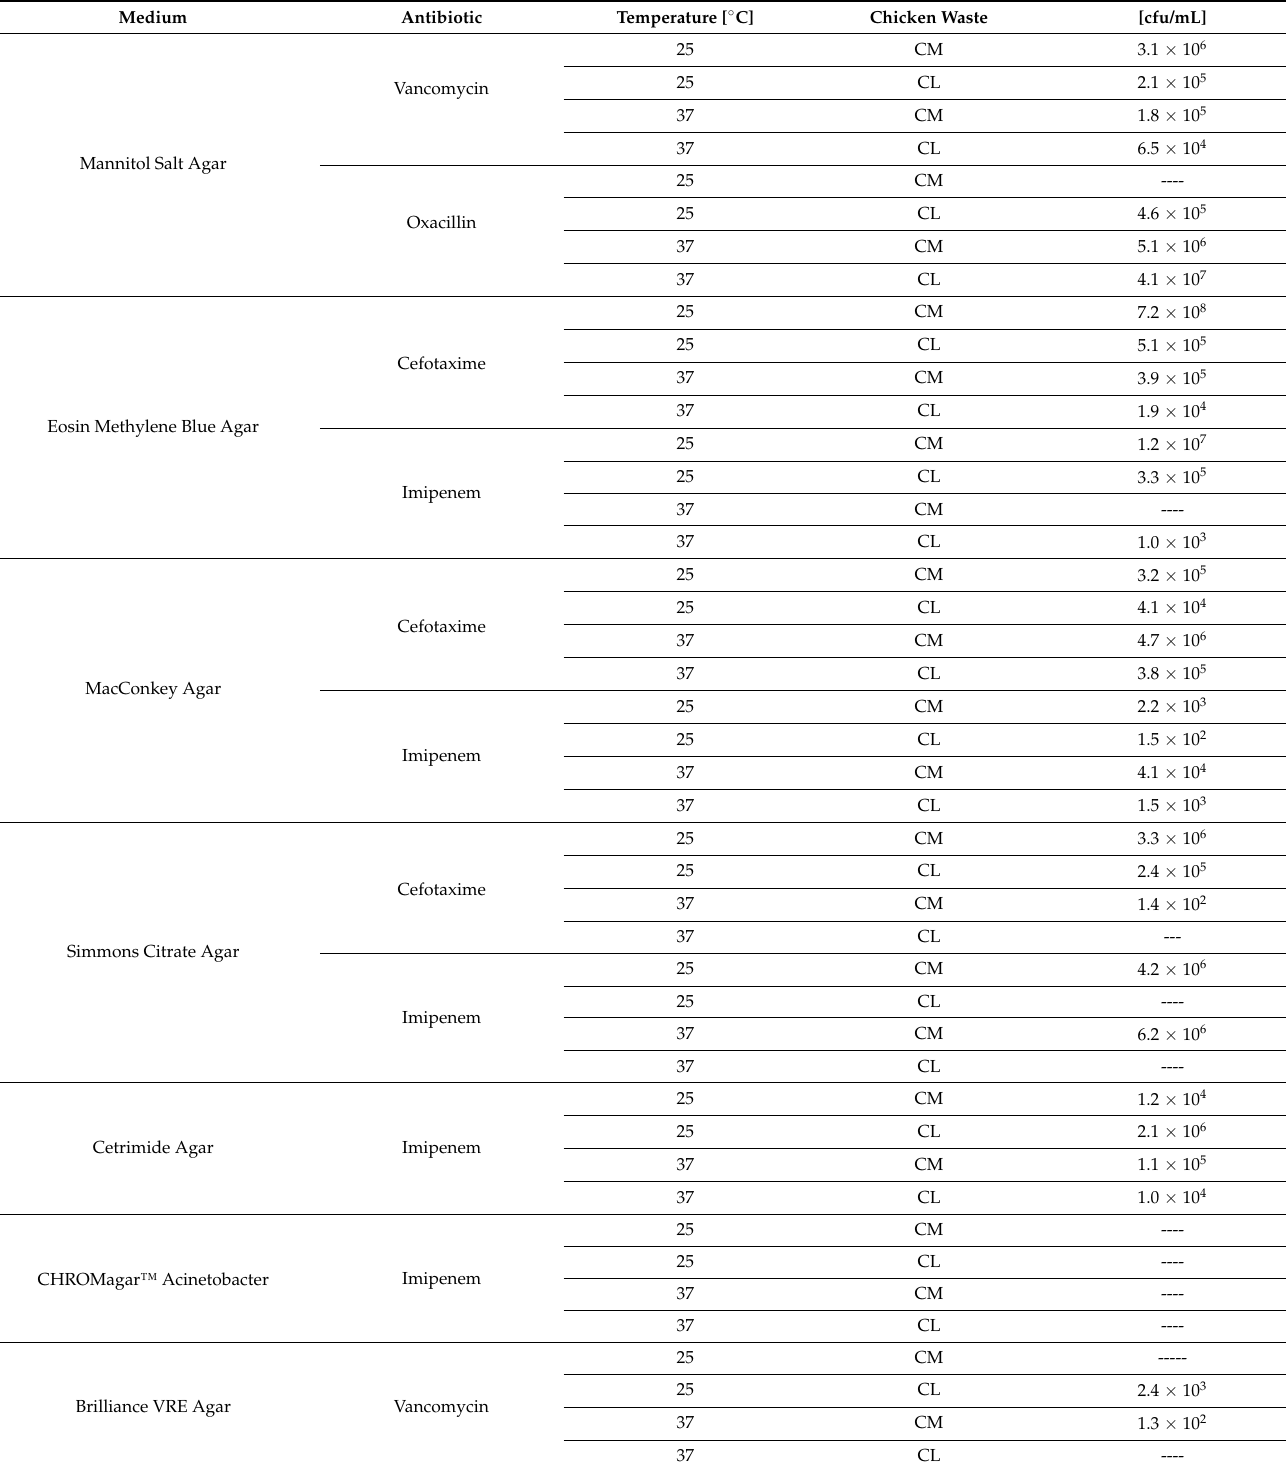
Table 3. Amount of bacteria isolated from each medium type, calculated as